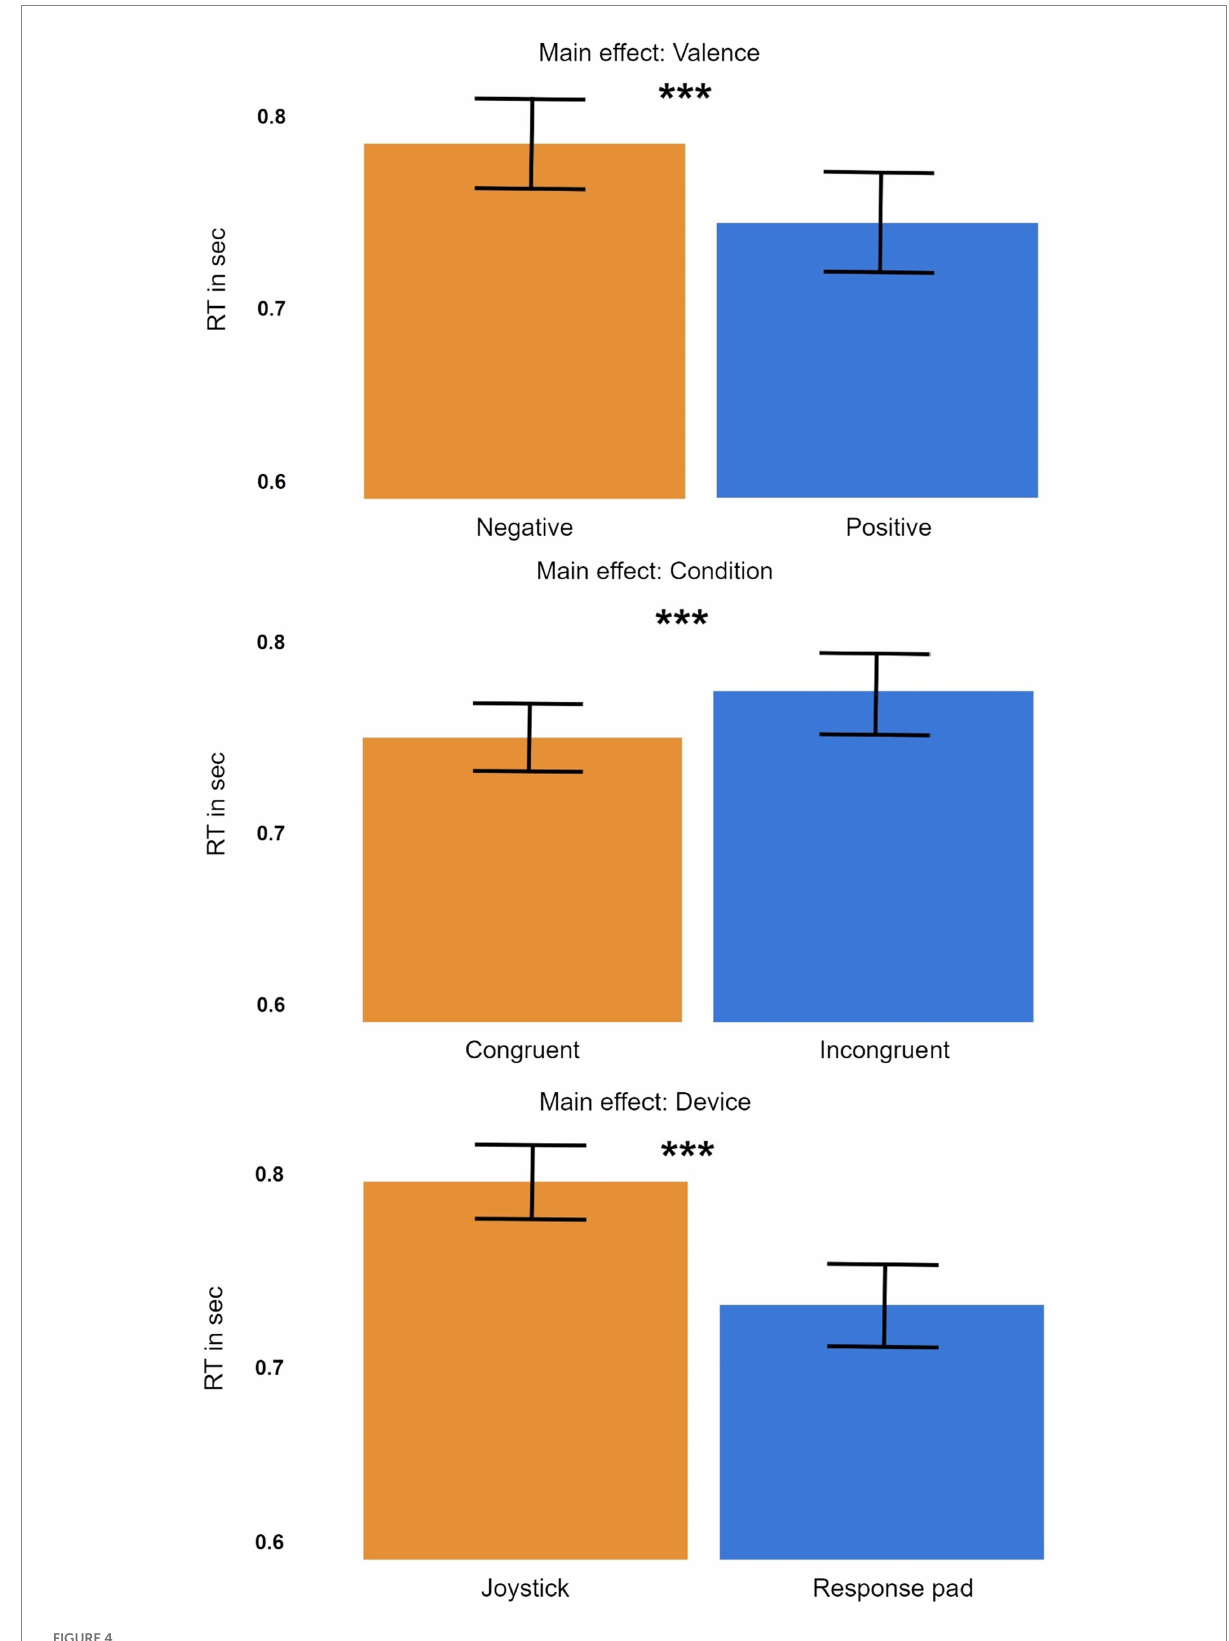
FIGURE 4 Main effects for device (joystick vs. response pad), condition (congruent vs. incongruent) and valence (positive vs.